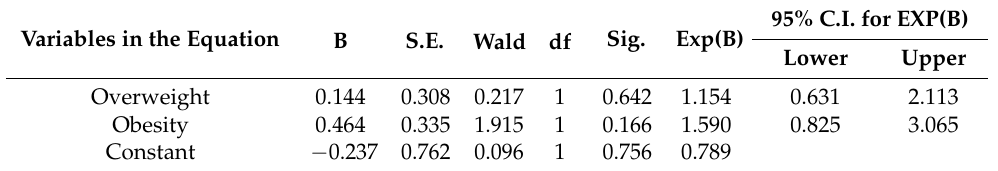
Table 4. Logistic regression analysis (Enter method) taking stroke as a dependent variable for patients with permanent AF for overweight and